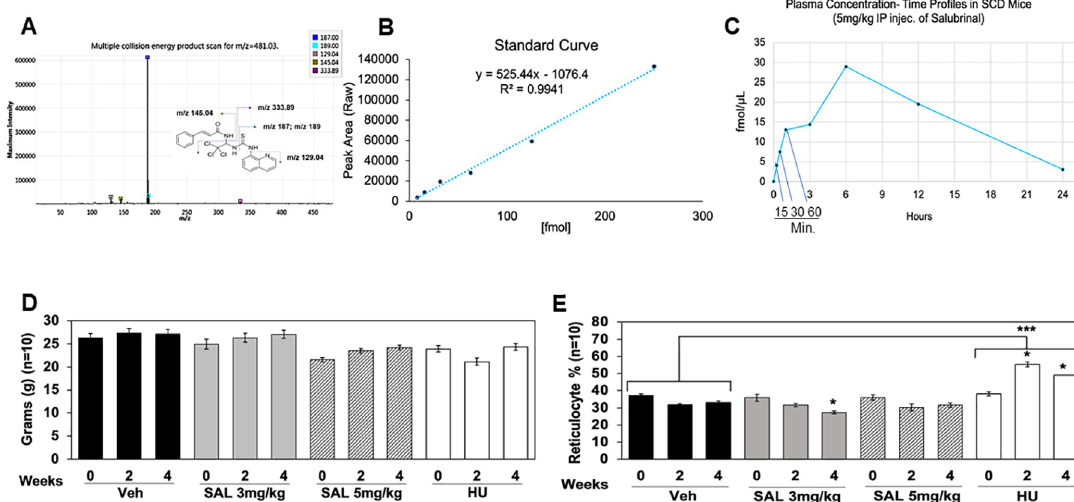
Fig 5. Plasma level of SAL in SCD transgenic mice and reticulocyte analysis. A) At the corresponding time points, blood was drawn by tail bleed into an EDTA tube. Plasma was immediately collected and 80 μ l acetonitrile was added to 20 μ l of mouse plasma and vortexed for 5 minutes. The samples were then centrifuged at 16,000g for 10 minutes and the supernatant was transferred into a glass vial for liquid chromatography- multiple reaction monitoring mass spectrometry. Multiple collision scan for the SAL molecule shows the different fragmentation by mass spectrometry. B) Shown is the standard curve used to determine plasma concentrations of SAL. C) The in vivo SAL levels were calculated from the standard curve (Panel B), using plasma isolated from peripheral blood of SCD mice. After establishing the plasma concentration of SAL, we next treated Townes SCD transgenic mice (4–6 months old) with SAL 3 mg/kg/ day and SAL 5 mg/kg/day dissolved in water, for 4 weeks by intraperitoneal (IP) injections. Water vehicle control (Veh) and positive control hydroxyurea 100 mg/kg/day (HU) treatments were completed. All treatment groups consisted of n = 10 mice with an equal sex distribution of 5 males and 5 females. D) Mouse weights in grams were obtained at week 0 (baseline), week 2, and week 4. E) Blood samples collected at weeks 0, 2 and 4 were stained with acridine orange for reticulocyte counts by flow cytometry. Data are shown as the mean ± SEM and brackets represent results of the ANOVA analysis across treatment groups. � p < 0.05 and ��� p < 0.001 was considered